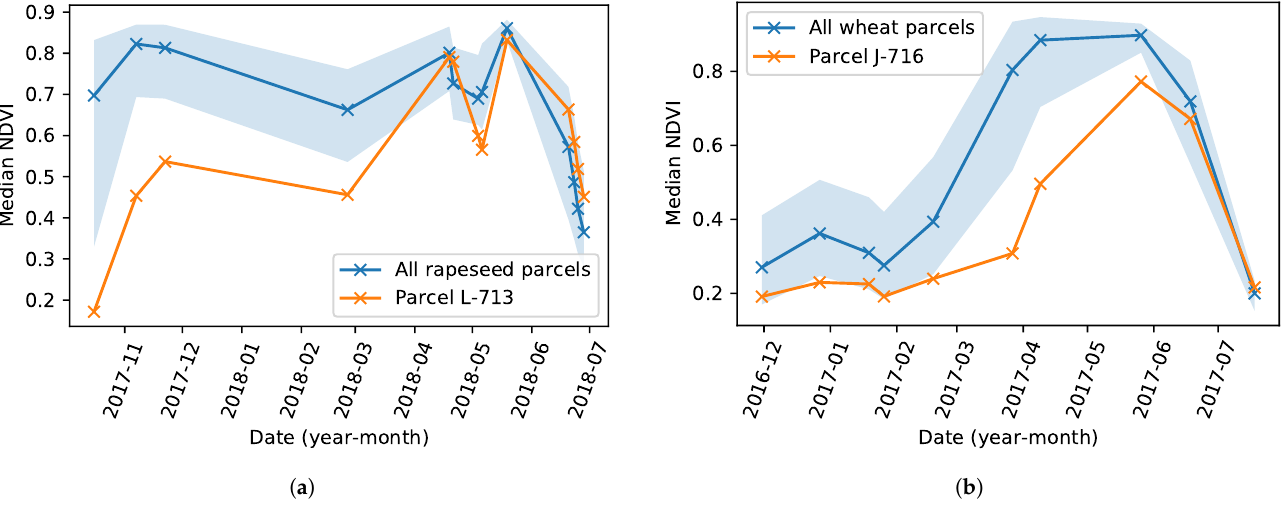
Figure 15. Median NDVI for late growth parcels ( a ) rapeseed parcel and ( b ) wheat parcel. The blue line is the median value of the whole dataset. The blue area is filled between the 10th and 90th percentiles. The orange line is a specific parcel